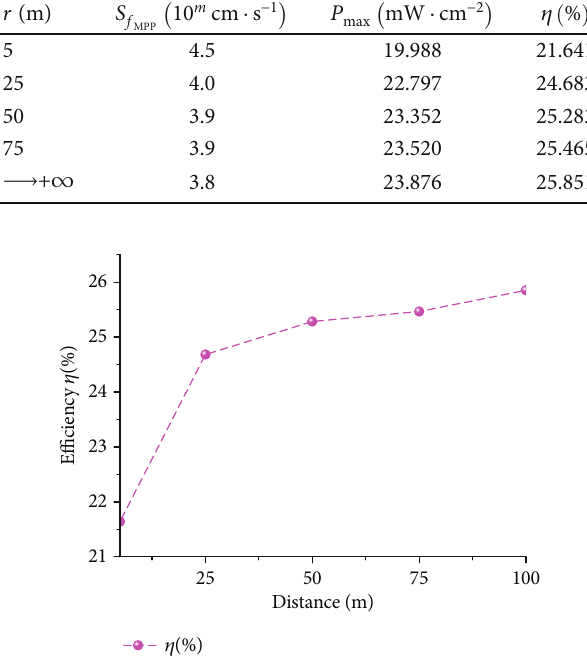
Table 1: Maximum power and conversion e ffi ciency for di ff erent